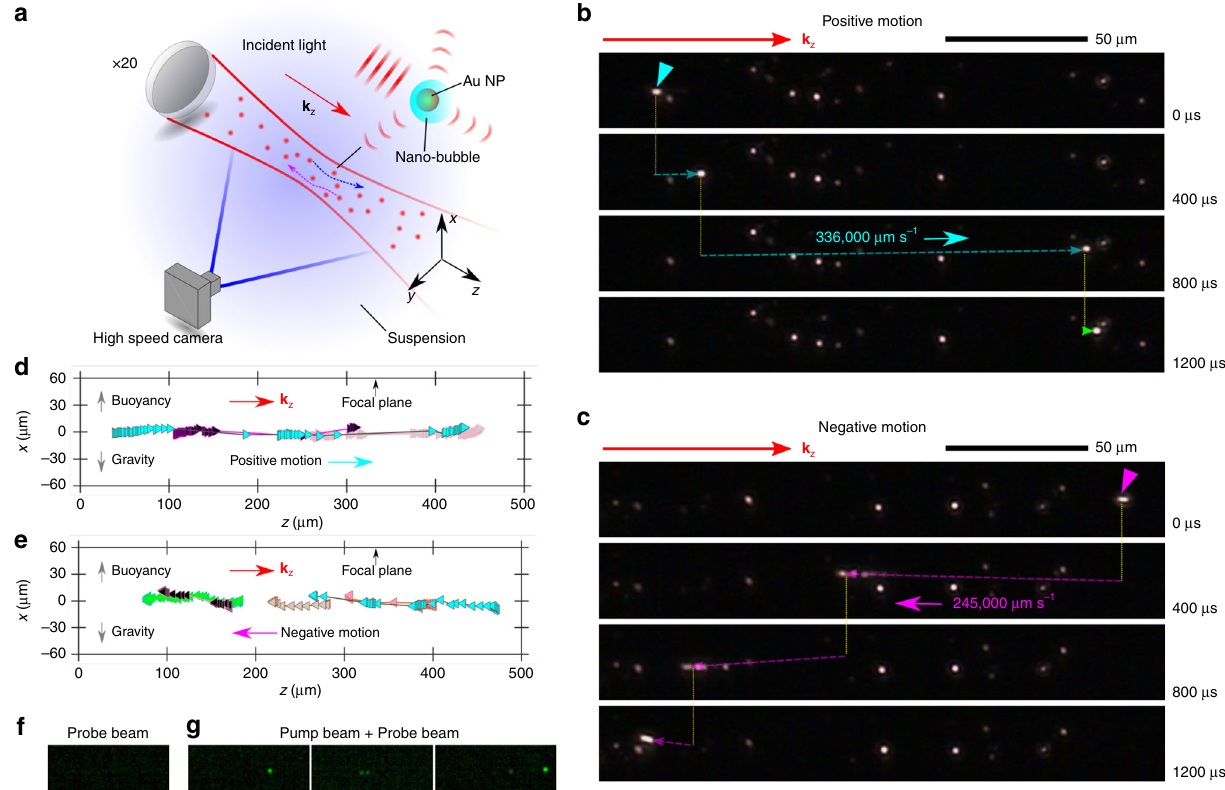
Fig. 1 Observation of extremely fast ballistic movements of Au NPs. a Schematic of the experimental system to monitor the dynamics of Au NPs dispersed in water. The red solid lines after the 20× lens indicate the Gaussian beam envelope. Au NPs scatter the incident light (red dots), which is captured by a high-speed camera with the fi eld of view depicted by the blue solid lines. The blue and magenta arrows depict the Au NPs moving in the + z and − z directions, respectively referred to as the “ positive motion ” and the “ negative motion ” . b , c Dark- fi eld optical images (scale bars – 50 μ m) of ultra- fast ballistic Au NPs with b the positive motion and c the negative motion. The cyan triangle in b and the magenta triangle in c indicate the positions of the selected Au NPs at t = 0. The cyan dotted line in b and the magenta dotted line in c are guide for the eye. The power of the laser is 690 mW, corresponding to 12 mW μ m − 2 at the focal plane. d , e Representative d positive and e negative motion trajectories of the ballistic Au NPs projected onto the x − z plane. Each color corresponds to a ballistic Au NPs. The time interval between two adjacent symbols is 400 μ s. The black arrows at the top of the fi gures indicate the focal plane location. In a – d , k z is the wavevector of the incident laser light. f , g Images from the pump-probe optical scattering imaging experiment for f without pump beam and g with pump beam. Each green spot corresponds to the diffraction-limited scattered probe light from the Au NPs with